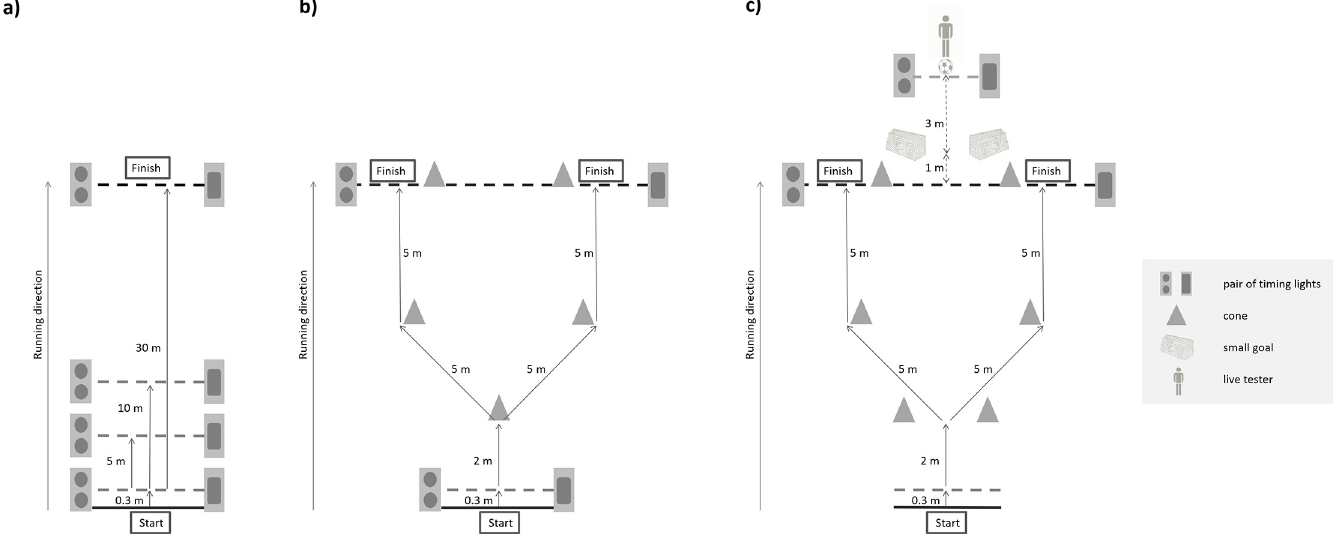
Fig 1. Schematic illustration of the three tests. a) Linear-sprint test (splits at 5 m, 10 m, and 30 m); b) Change-of-direction test (12 m with 2 pre-planned directional changes of 45˚ at 2 m and 7 m); c) Soccer-specific agility test (same movement pattern as the change-of-direction test but with the inclusion of a human stimulus performing passing movements to which the players were instructed to respond